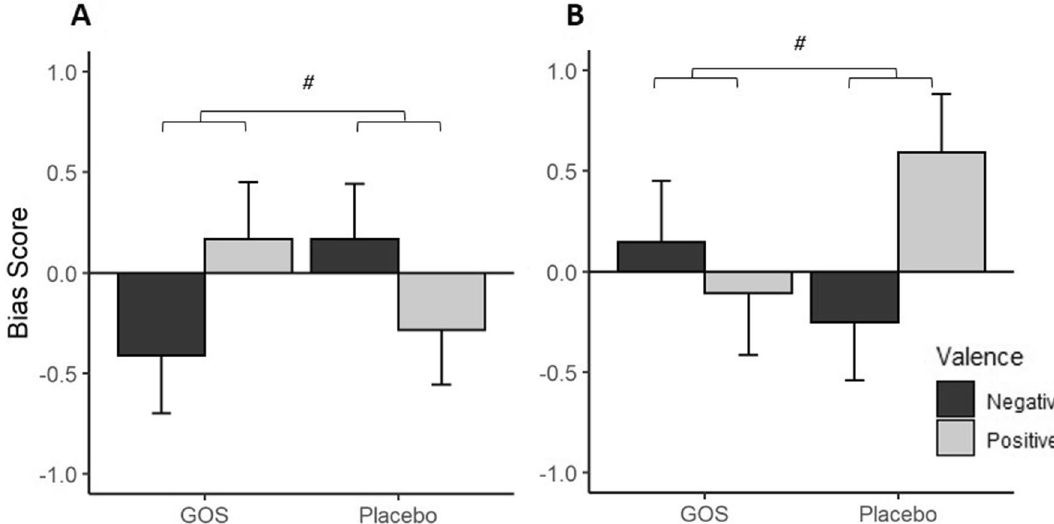
Figure 1. Interaction of attentional vigilance to stimulus valence (y-axis, bias score (z-scores)) by intervention group in the high anxious group ( A ), and the low anxious group ( B ) at follow-up. Error bars illustrate SE ( A ), high anxious GOS group shows a trend towards reduced bias to negative stimuli, and increased bias to positive stimuli in comparison to the placebo group. *p = 0.070. ( B ) Low anxious Placebo group shows a trend towards reduced bias to negative stimuli, and increased bias to positive stimuli in comparison to the GOS group. *p = (GOS M = − 34.86 ms, SE = 18.86 [CI − 72.86 to 3.13]; Placebo M = 3.67 ms, SE = 18.18 [CI − 32.95 to 40.29]) and greater bias to positive stimuli, (GOS M = 3.62 ms, SE = 18.90 [CI − 34.45 to 41.69]; Placebo M = − 26.36 ms, SE = 18.09 [CI − 62.82 to 10.08]). The trend towards interaction between intervention group and valence condi- tion was also found in the low anxious group ( F (1,41) = 3.49, p = 0.069, n 2 = 0.073). Unlike in the high anxious